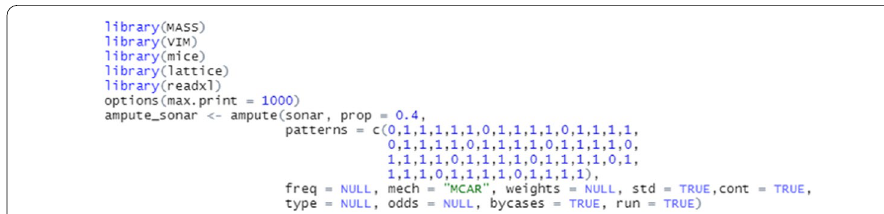
Fig. 7 The pseudo-code for generate missing values with R